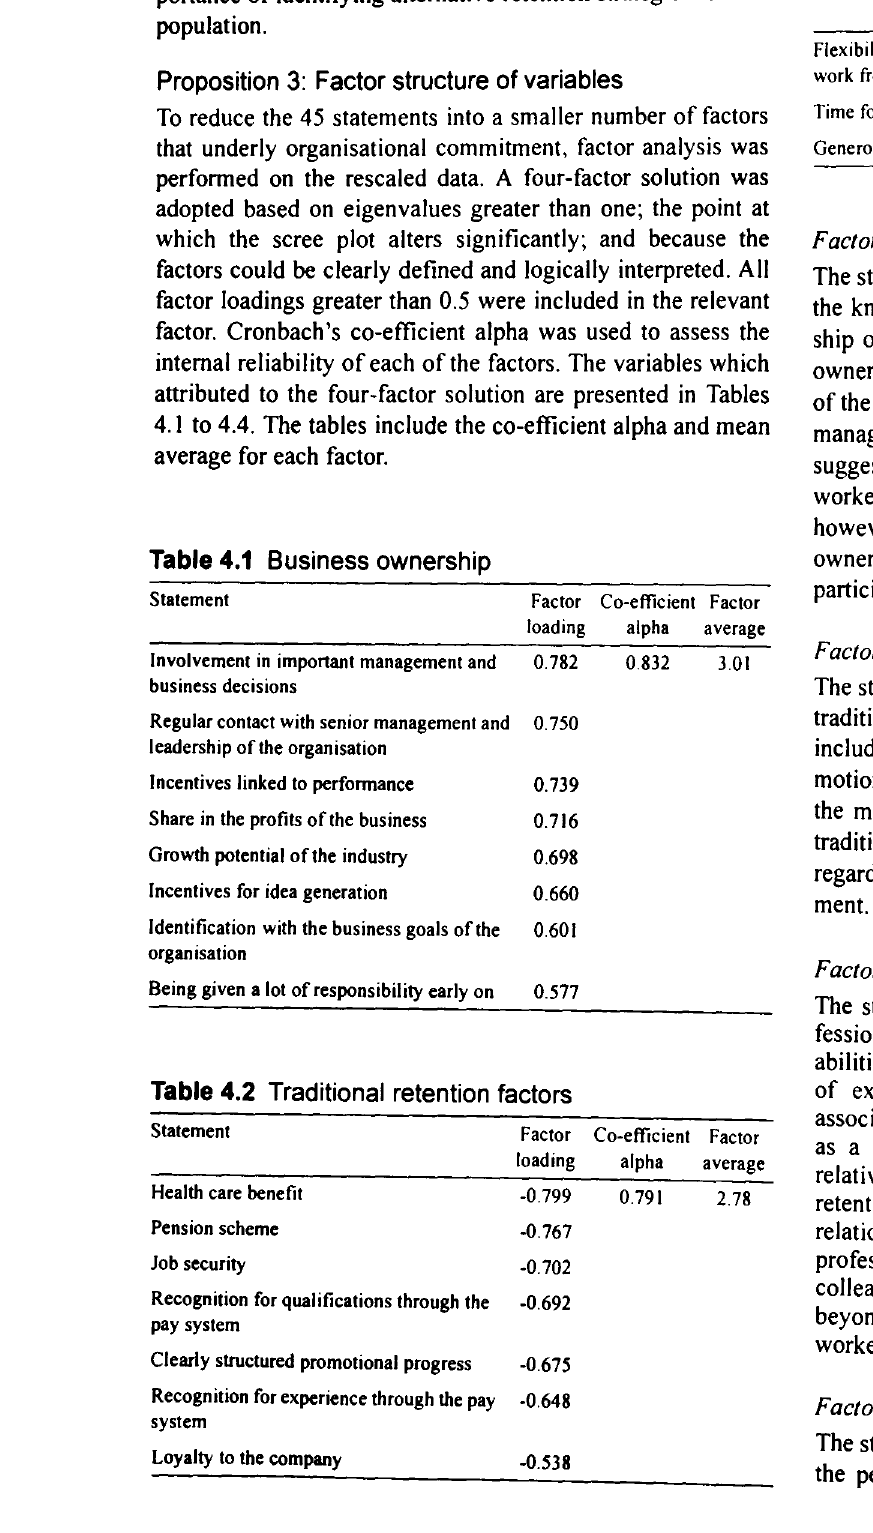
Table 4.2 Traditional retention